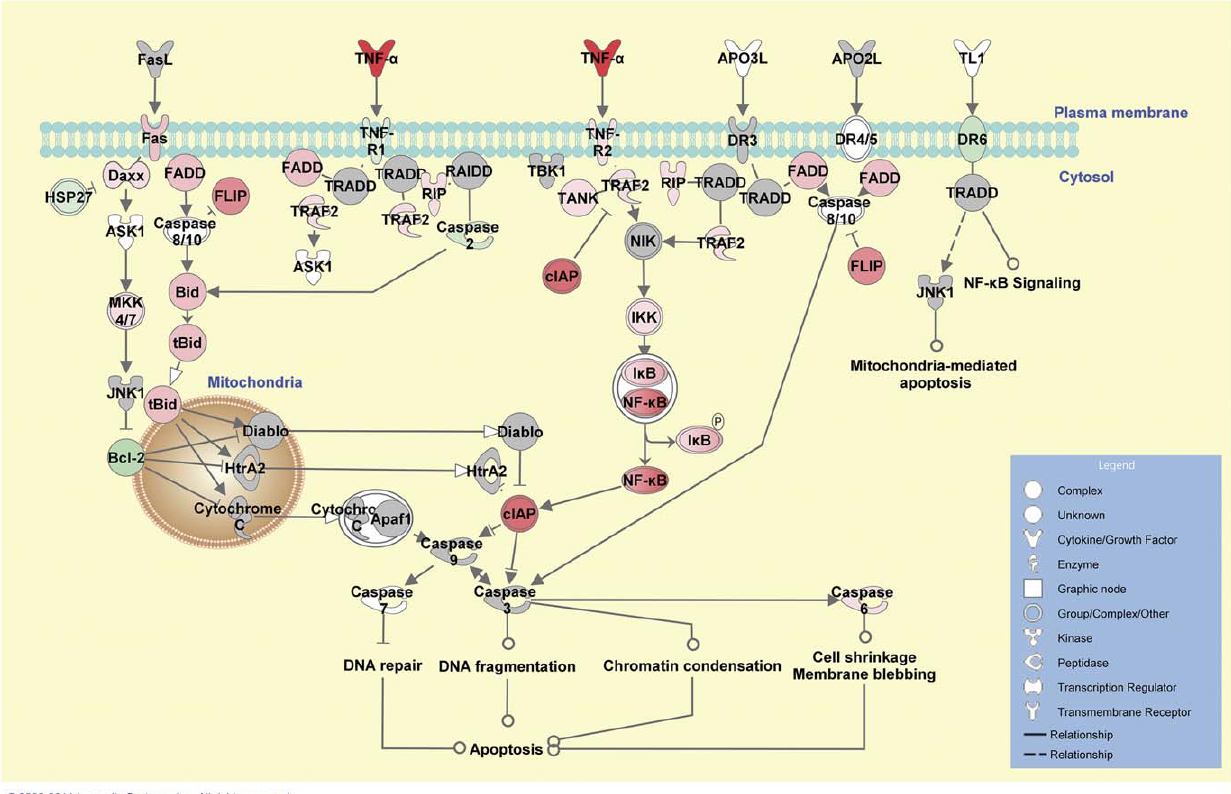
Figure 5. Differential gene expression associated with apoptosis 6 hours post- M.bovis challenge. Genes associated with apoptosis showing differential expression are highlighted in colour. Colour intensity indicates the degree of upregulation (red) or downregulation relative to the control MDM. Grey shading indicates genes that were not differentially expressed; white shading represents genes in the pathway not represented on the microarray.